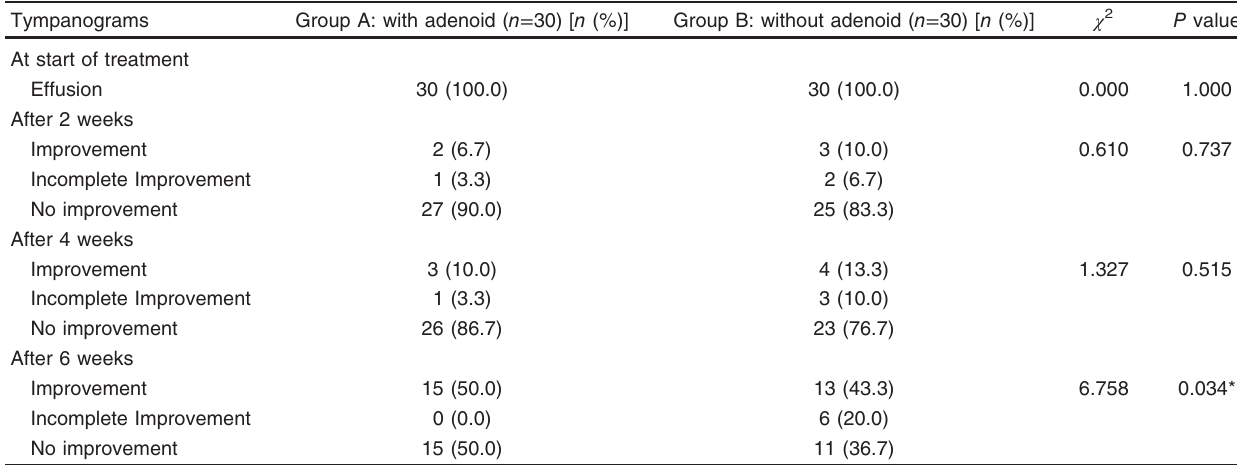
Table 5 Comparison between group A, with adenoid, and group B, without adenoid, according to